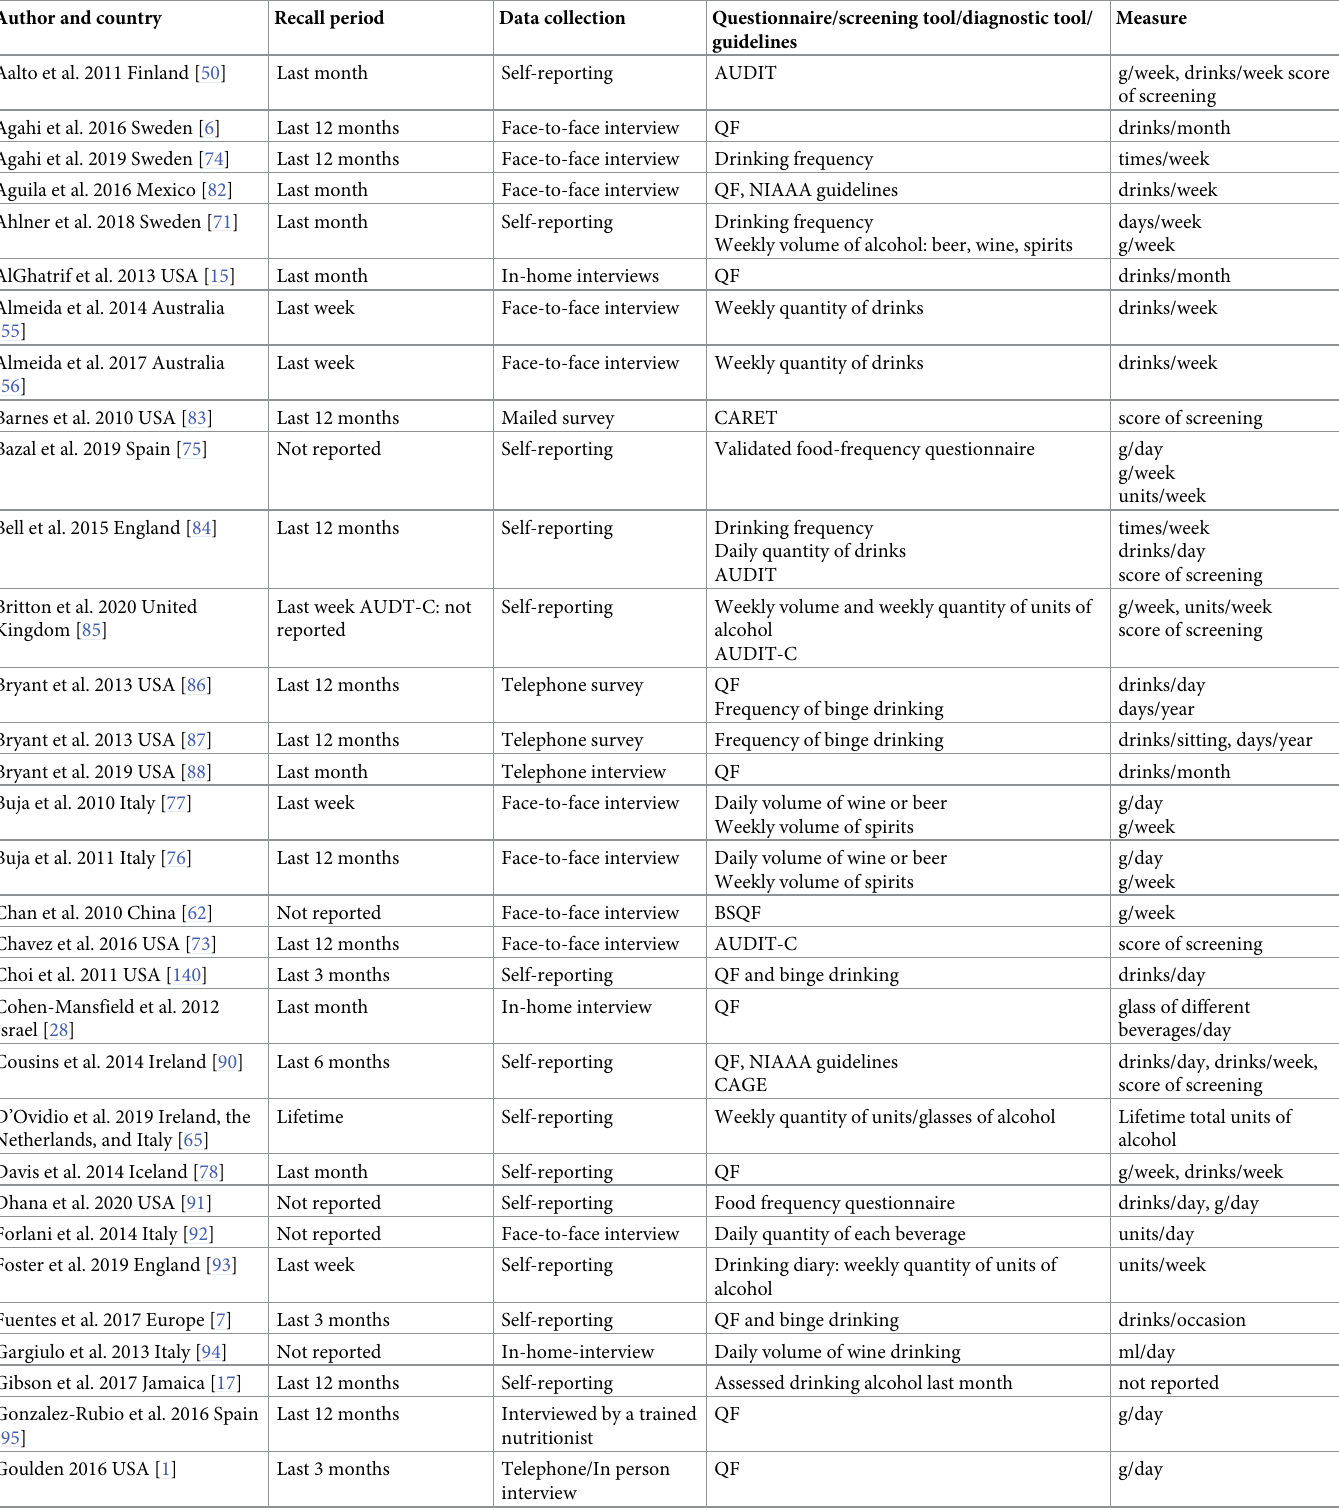
Table 3. Method and measure of alcohol consumption in older